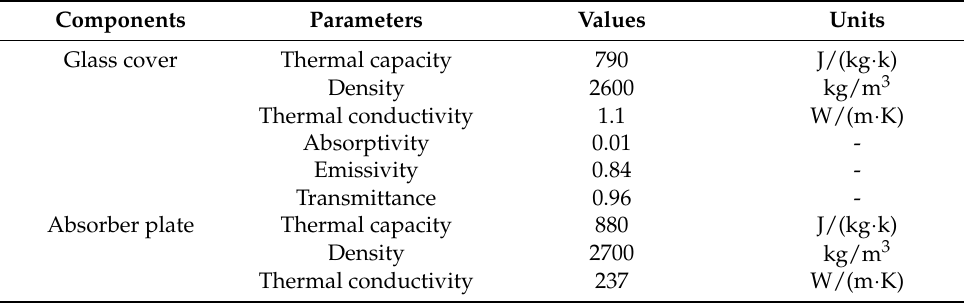
Figure 1. Structure of the ASTF module. Table 1. Thermo-physical properties of different layers of the ASTF